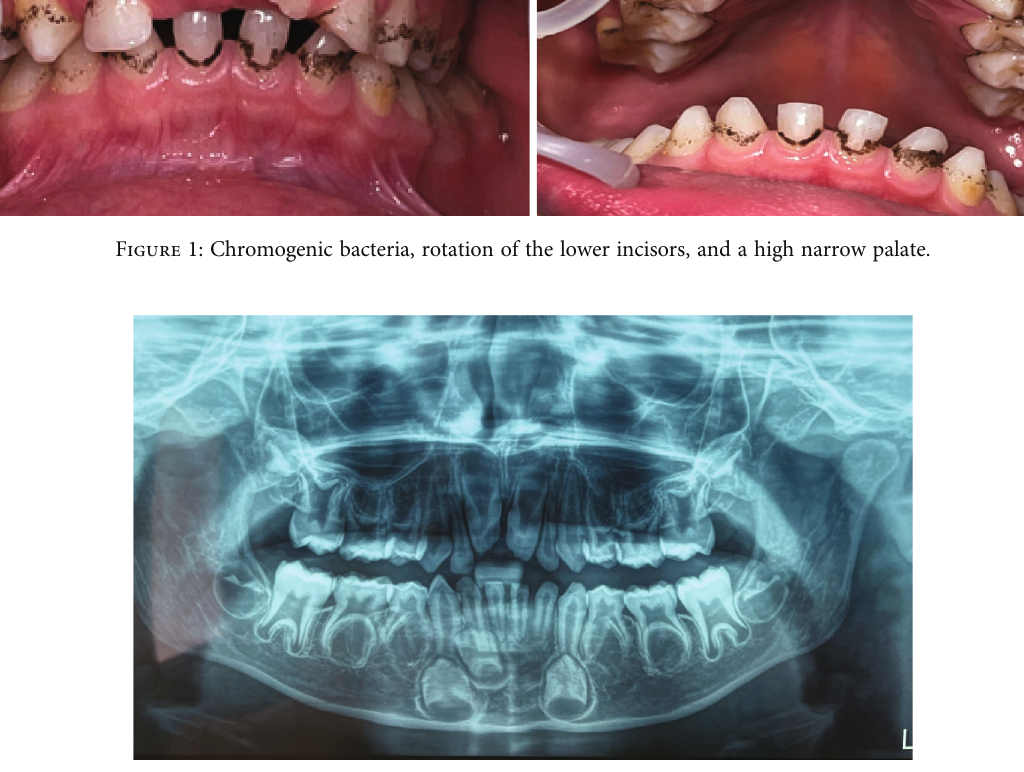
Figure 2: Panoramic radiographic view demonstrating oligodontia, chronologically delayed eruption, and